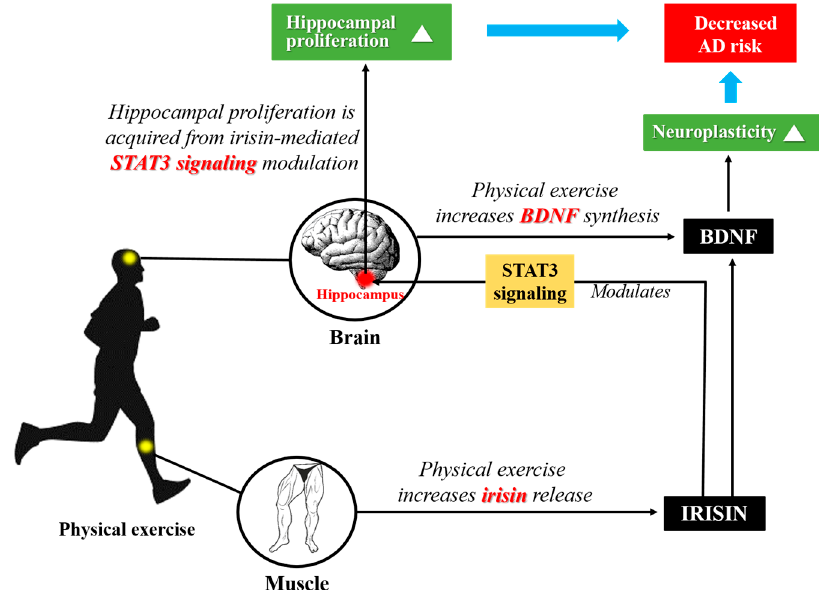
Figure 2. Exercise-irisin-BDNF axis. Physical exercise increases irisin levels and BDNF synthesis. In turn, irisin enhances BDNF synthesis and release, leading to augmented neuroplasticity achieved by the collaboration of irisin and BDNF. Additionally, irisin modulates STAT3 signaling leading to hippocampal proliferation. In this context, exercise and its sequelae, irisin and BDNF, may contribute to neuroplasticity and reduce the risk of AD. AD, Alzheimer’s disease; BDNF, brain-derived neurotrophic factor; STAT3, signal transducer and activator of transcription 3.